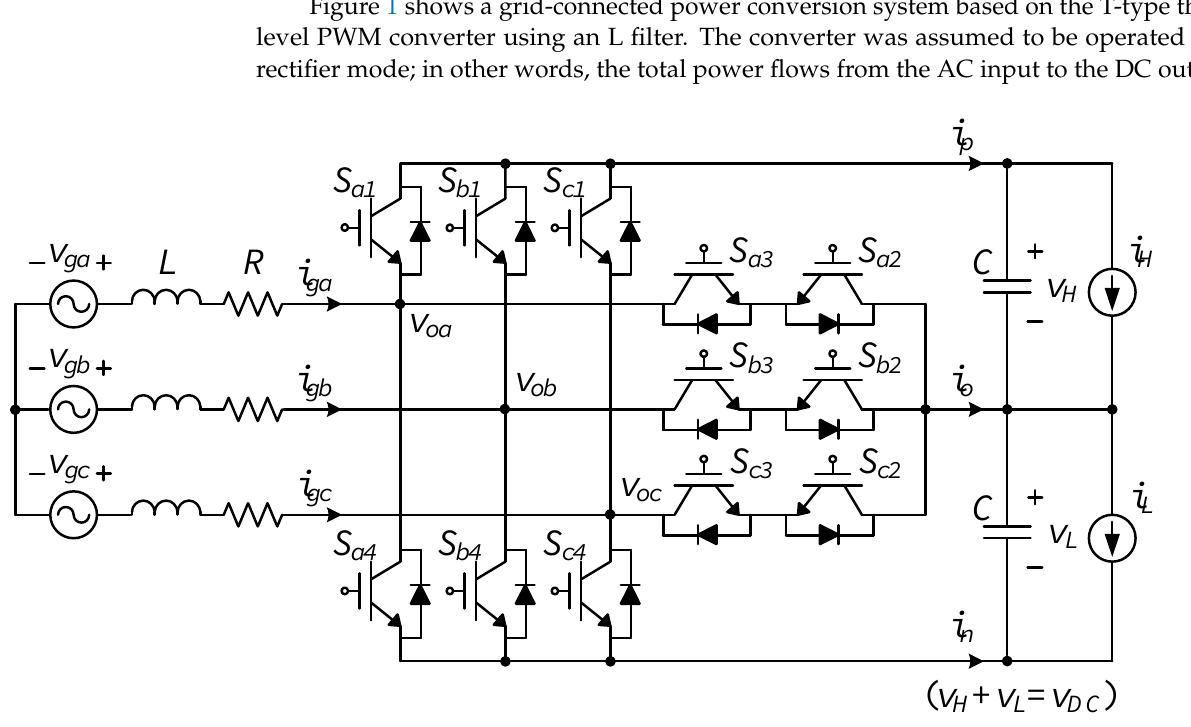
Figure 1. T-type three-level PWM converter system.